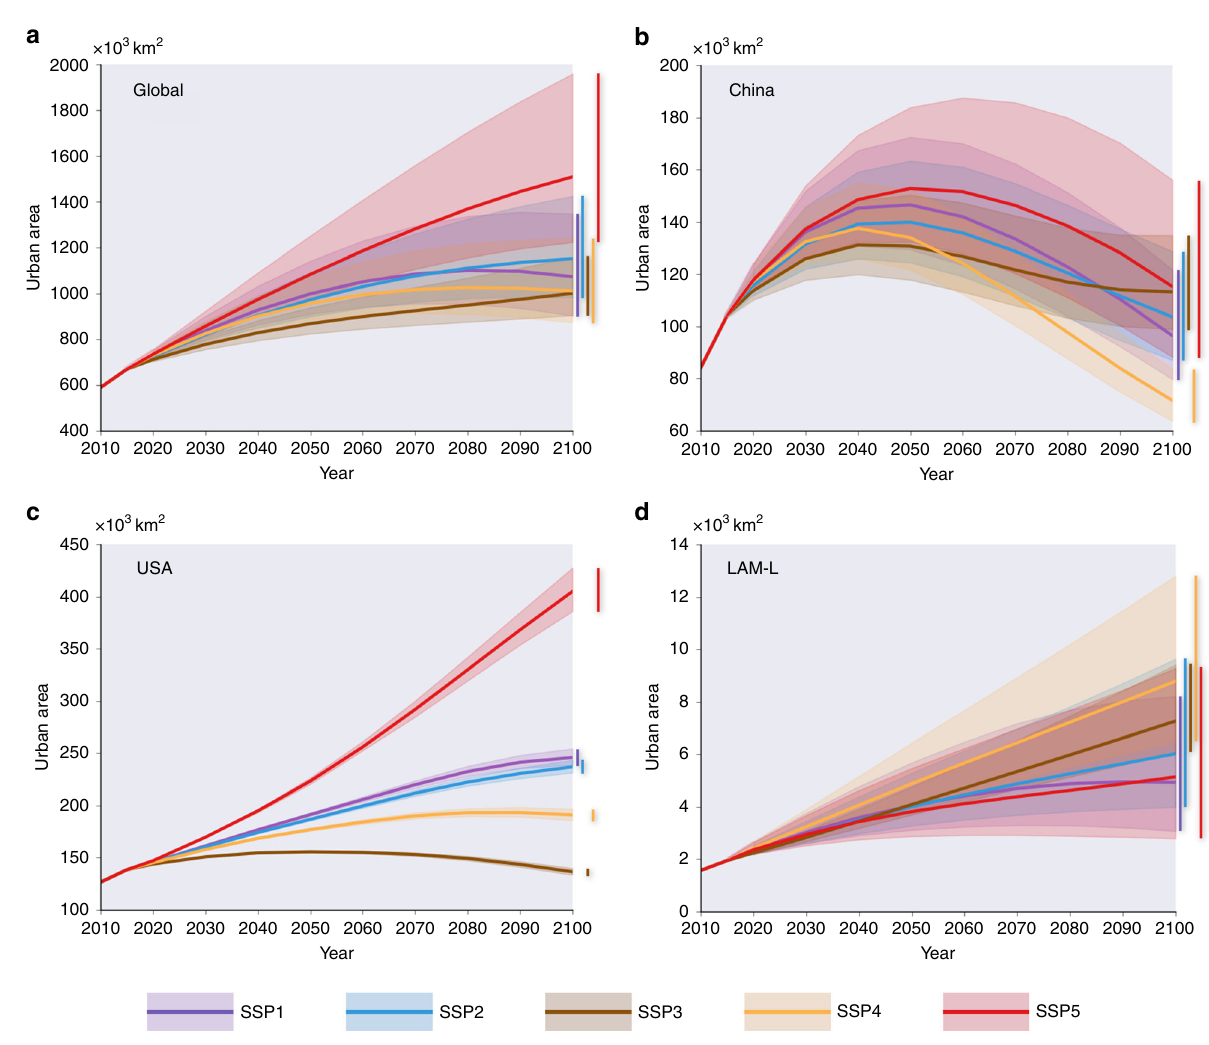
Fig. 1 Projections of urban land demand globally and in the representative macro regions for 2010 – 2100 under the SSP scenarios. a Global, b China, c USA, d the region LAM-L consists of the low-income countries of Latin America, including Belize, Guatemala, Haiti, Honduras and Nicaragua. The shaded areas represent the 95% con fi dence intervals of the projected urban land